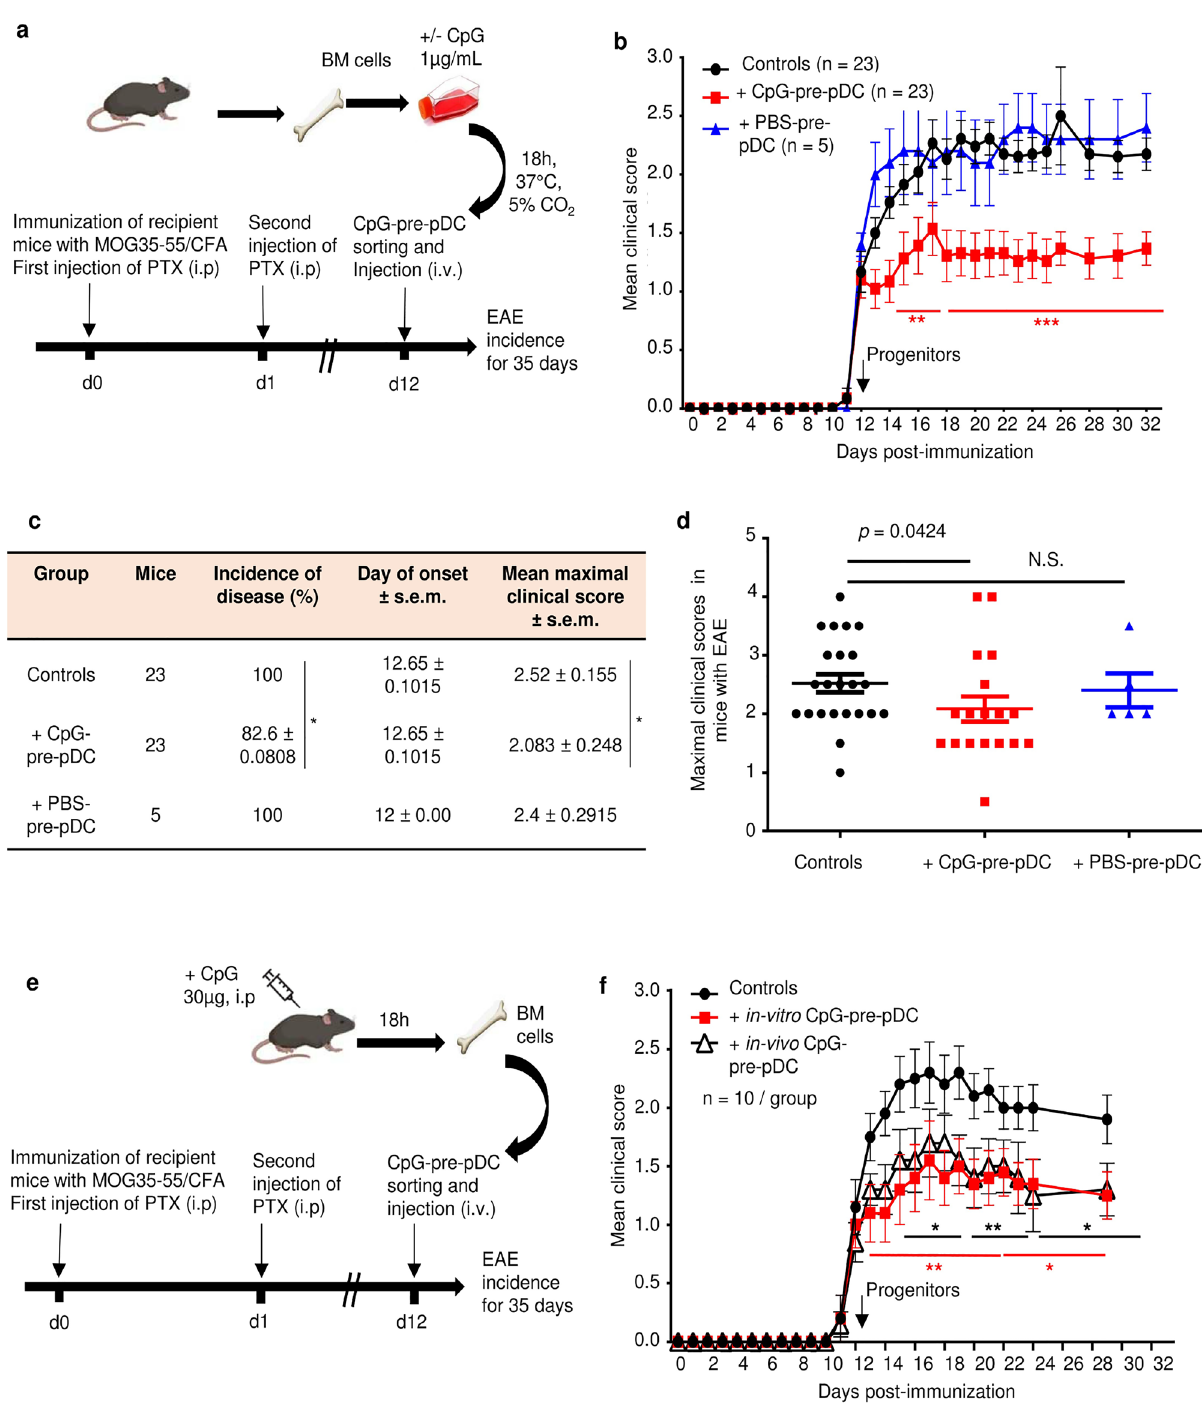
Figure 2. EAE disease protection by pDC progenitors. c-kit + Sca-1 + B220 int PDCA-1 + cells were cell-sorted as in Fig. 1a from ( a ) BM cells stimulated in vitro for 18 h with CpG-B (1 µg/ml) or PBS, and 80,000 cells injected iv into MOG 35–55 -immunized mice at the onset of EAE clinical signs (d-12) . Controls are mice immunized for EAE but injected with PBS medium only. ( b ) EAE clinical scores (mean ± s.e.m.) were measured over 35 days for MOG 35-55 immunized C57Bl/6 J mice and injected with CpG-pre-pDCs (n = 23 mice per group) or PBS-pre-pDCs (n = 5 mice) or PBS (controls, n = 23 mice), data obtained from three cumulated experiments. Statistical analysis was performed using two-way ANOVA with Bonferroni post-test, d14–d17, **, p < 0.004, d18–d30 ****, p = 0.0003 when comparing CpG-pre-pDC injected mice with controls ( c , d ) Incidence of disease, and mean clinical scores in mice with EAE, but not day of onset were significantly modified by CpG-pre-pDCs but not by PBS-pre-pDCs, *, p = 0.0458, for incidence of disease, by Log- rank test and *, p = 0.0424, for maximal clinical score between controls vs CpG-pre-pDC recipients, by Mann–Whitney test. ( e , f ) BM cells isolated from mice 18 h after in vivo injection of CpG-B (30 μg/mouse, i.p.) were compared with in vitro-induced CpG-pre-pDCs for their effect on EAE upon injection at d-12 (n = 10 mice/group). Two cumulated experiments. Statistical analysis was performed using two-way ANOVA with Bonferroni post-test, Controls vs in vitro prepared CpG-pre-pDCs: d13–d21 **, p < 0.004, d23–d29 *, p = 0.0177; Controls vs in vivo prepared CpG-pre-pDCs: d14–d17 *, p < 0.032, d19–d21**, p < 0.0018, d23–d29, *, p < 0.047. Mice in ( a ) and ( e ) were created with